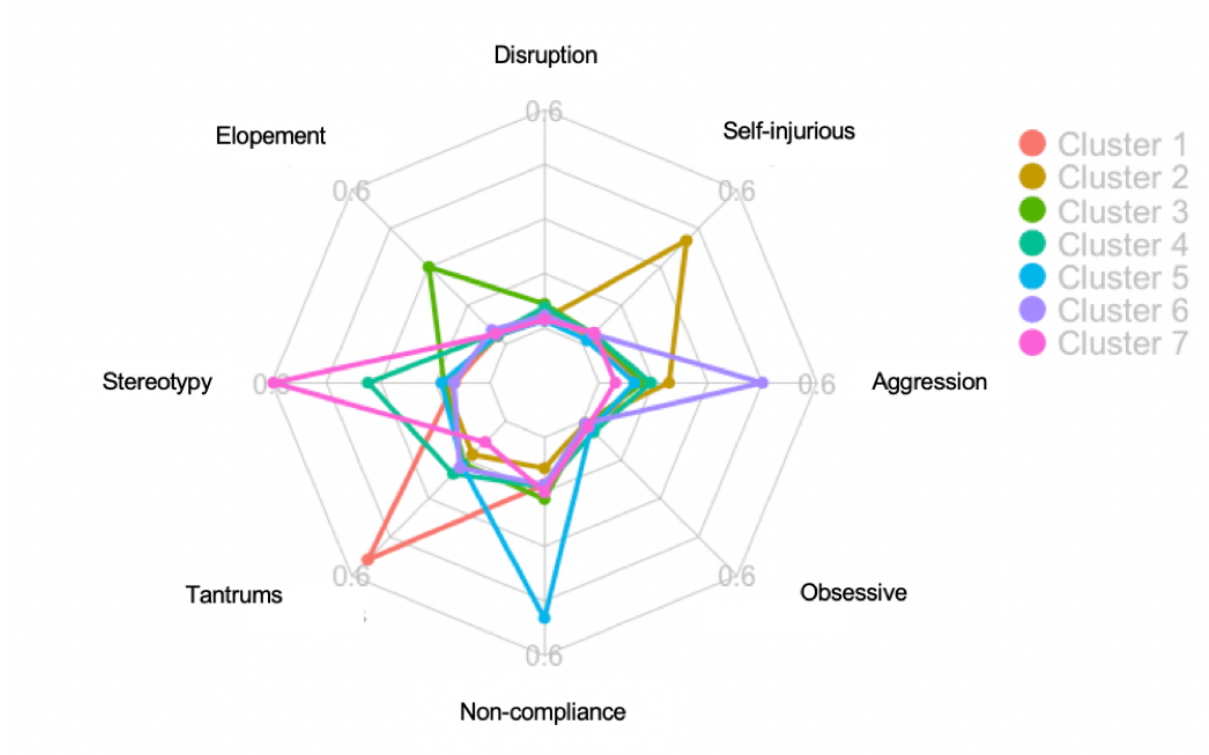
Figure 2. Radar graphs depicting engagement in challenging behaviors across